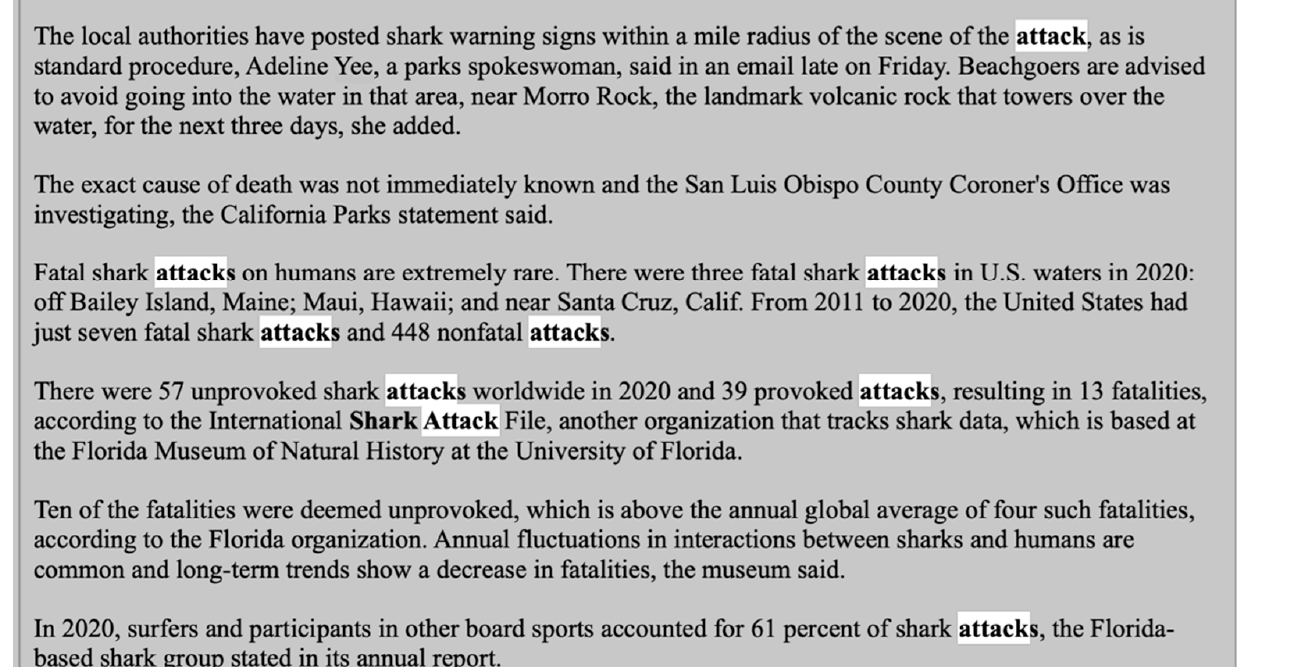
Figure 2. New York Times article with “attack” highlighted in the text.